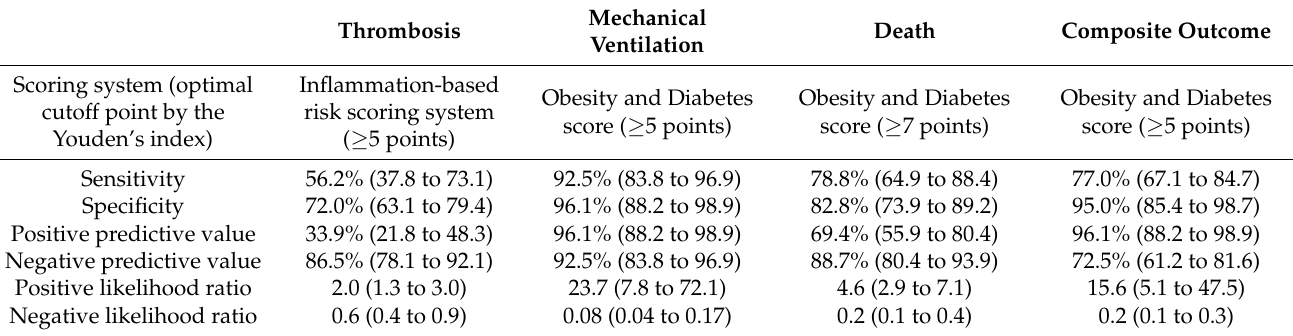
Table 4. Attributes as a diagnostic test of the risk scoring system that worked best to predict each major outcome.